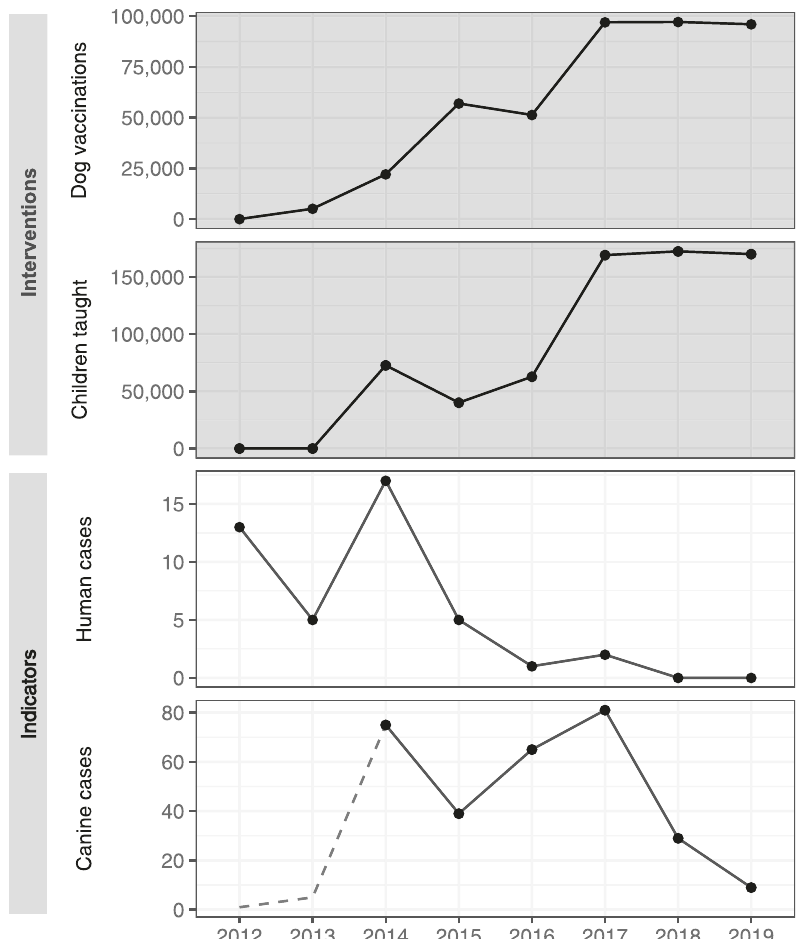
Fig. 7 Year-wise graphs of intervention outputs and indicators of rabies control from 2012 - 2019. Graphs show intervention outputs (dark background) of annual total dog vaccinations and children taught about rabies and indicators of rabies control (light background) of annual human rabies deaths and con fi rmed canine rabies cases. The dotted line in canine cases indicates a period prior to the enhancement of animal rabies surveillance activities. The decrease in canine rabies cases in 2015 is due to the cessation of canine rabies surveillance activities between October 2014 and September